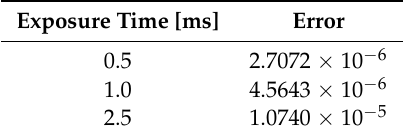
Table 9. RedEdge-3 exposure time errors for various settings. Errors were computed using an oscilloscope and measuring the line produced by a moving dot. A positive correlation can be seen between exposure time and error.